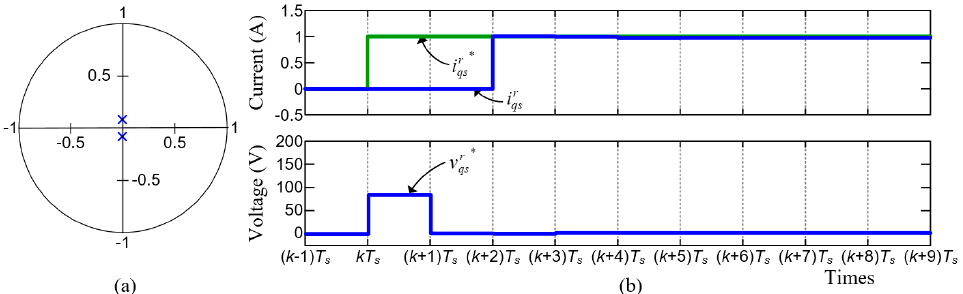
Figure 11. ( a ) The dominant poles and ( b ) simulated q -axis current and voltage command with ˆ r s = 0.5 r s when the current command steps from 0 A to 1 A. The motor is at standstill.